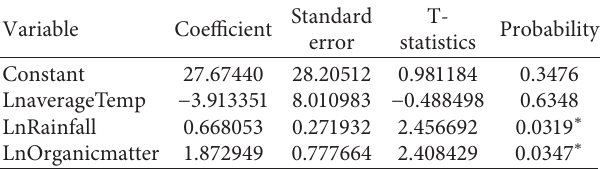
Table 7: Regression statistics for millet production. Table 6: Regression statistics for maize